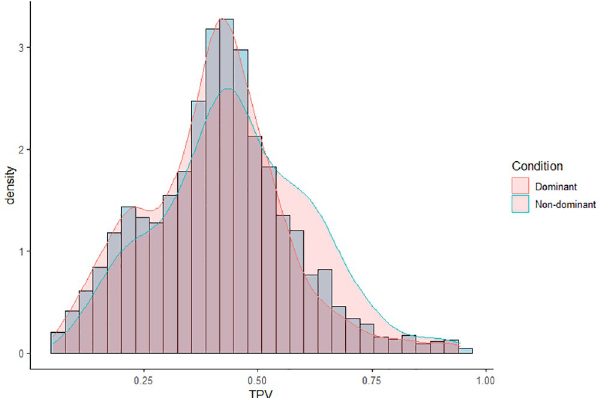
Fig 3. Distribution of the TPV values ( n